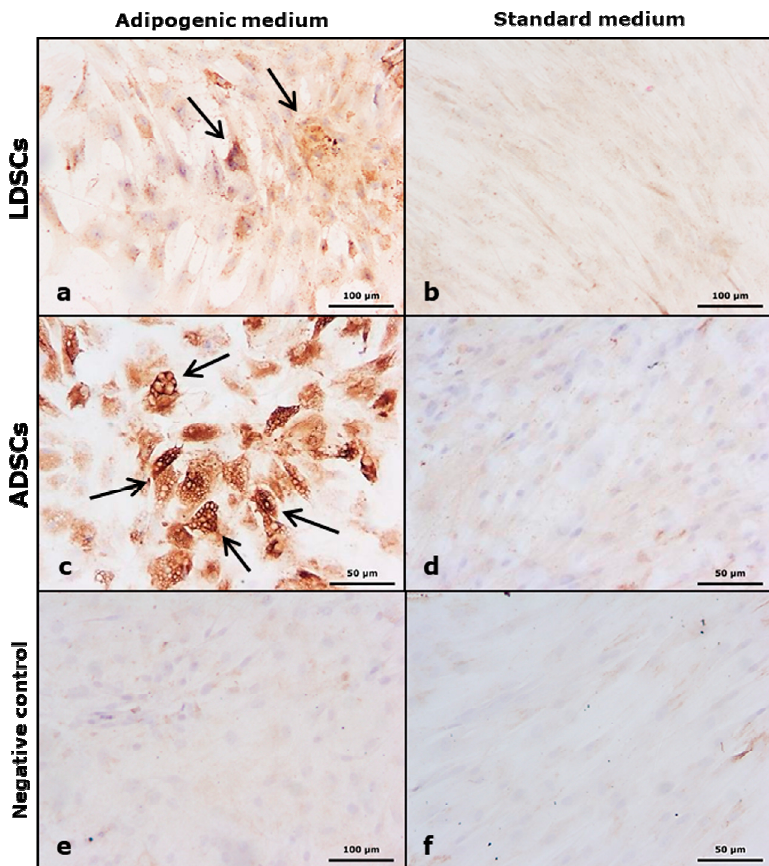
Figure 6. Immunoexpression of adiponectin in cells after 21 day of adipogenic differentiation; LDSCs in adipogenic medium (AM) ( a ), LDSCs in standard medium (DM) ( b ), ADSCs in AM medium ( c ) and ADSCs in DM medium ( d ); cells stained without primary antibody (non-specific background staining control – negative control) in AM medium ( e ) and in DM medium ( f ); bright field with objective magnification 20×; arrows indicate positive adiponectin immunostaining (brown).